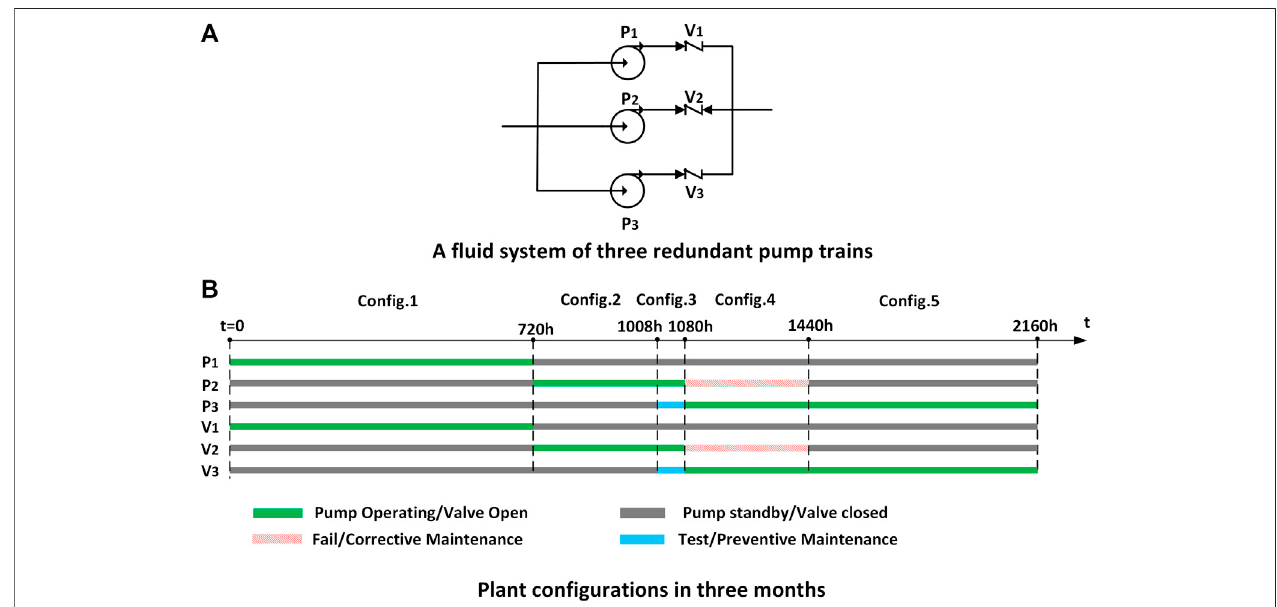
FIGURE 4 | Description of fl uid system. (A) A fl uid system of three redundant pump trains. (B) Plant con fi gurations in three months.